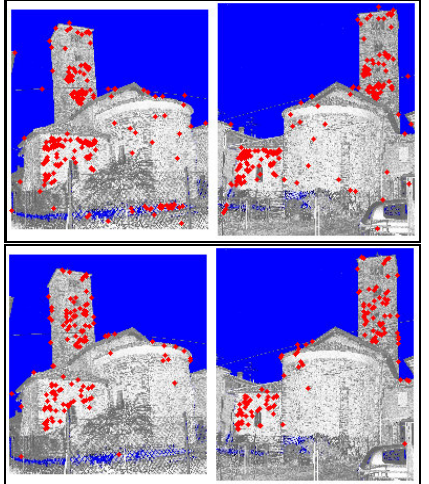
Figure 1. Key-points matched with both SIFT (top) and SURF (bottom) operators.